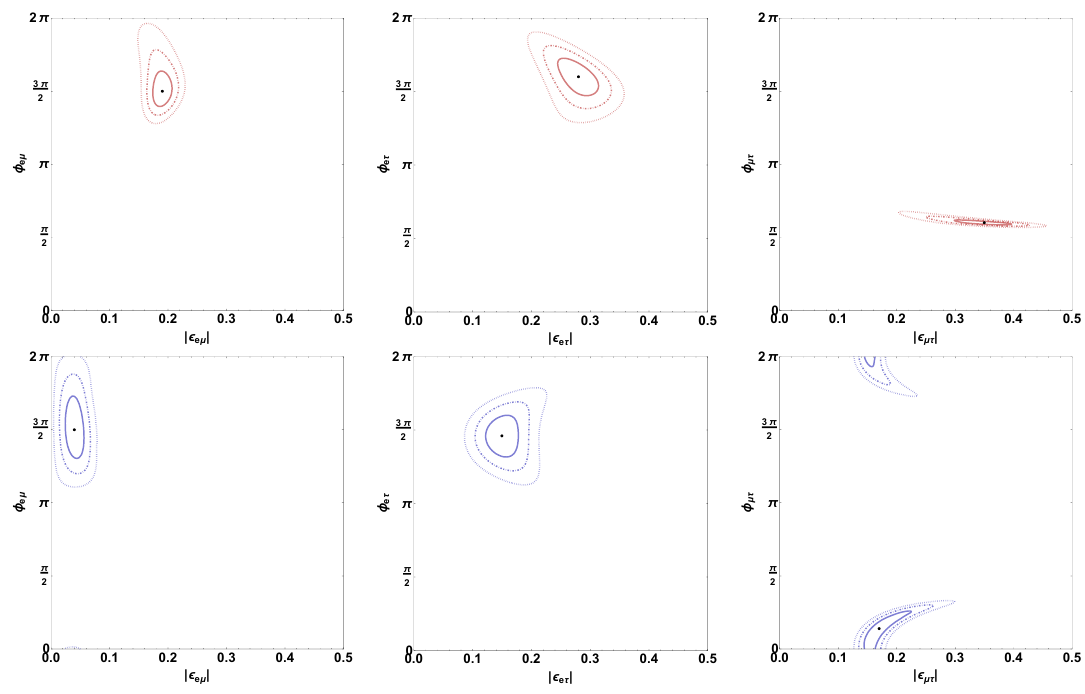
Figure 2 . 68% (solid lines), 95% (dashed lines) and 99% (dotted lines) contours in DUNE in the vector NSI ( | ε ) -planes when data are generated using vector NSI best fits considering one ij | − φ ij parameter at a time. The top (bottom) panels with red (blue) contours have been obtained using NO (IO) best